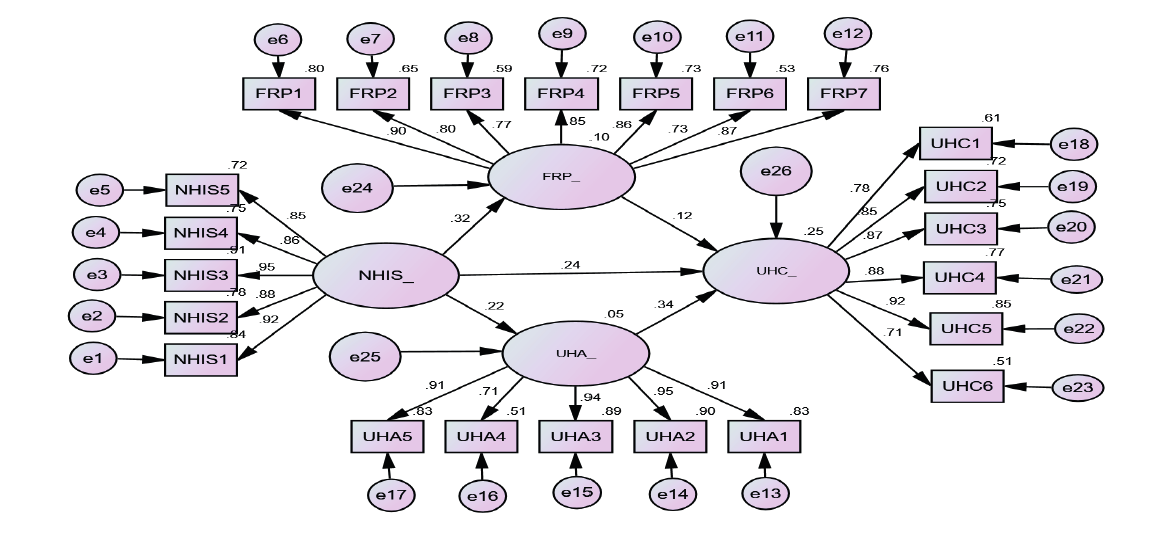
Figure 2. Standardized path of the hypothesized